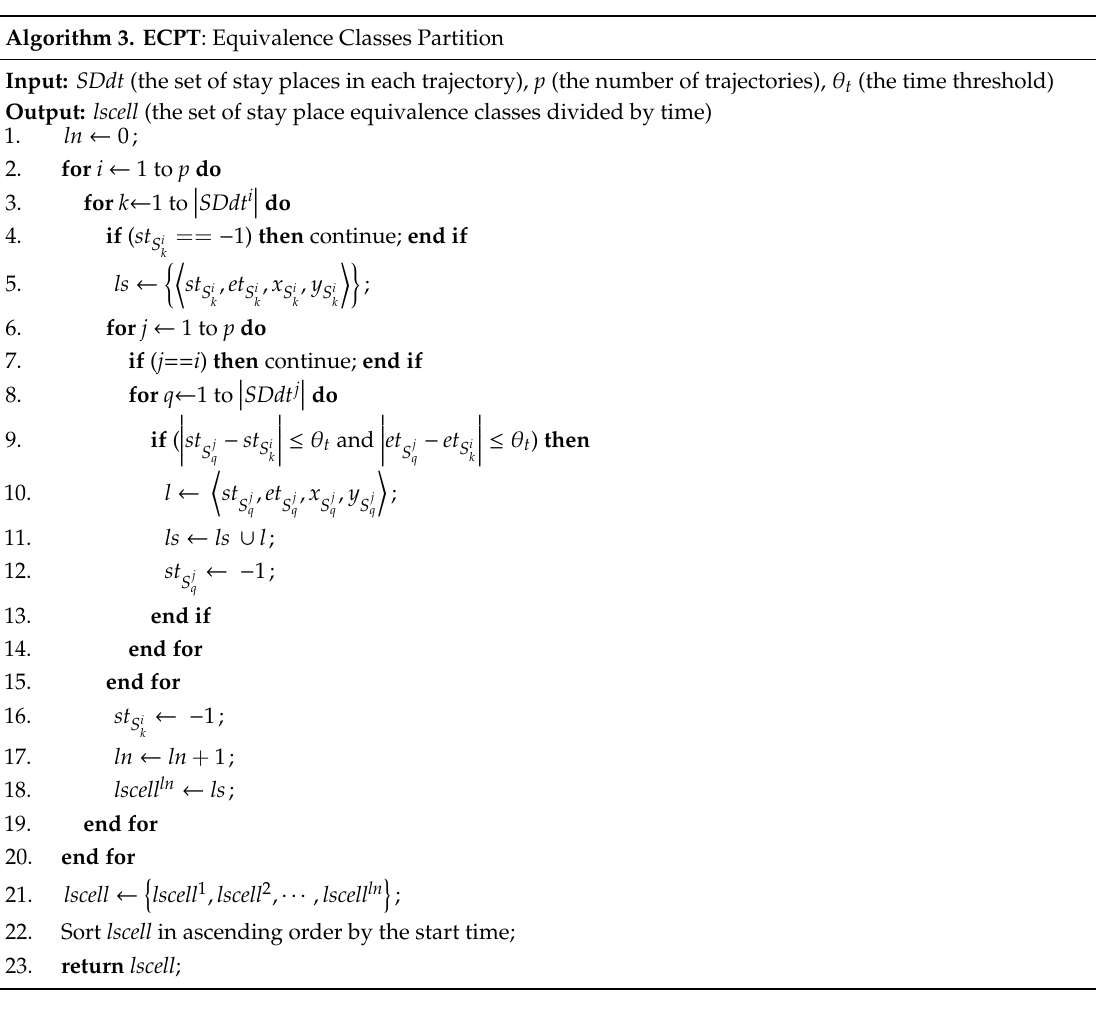
Algorithm 3. ECPT : Equivalence Classes